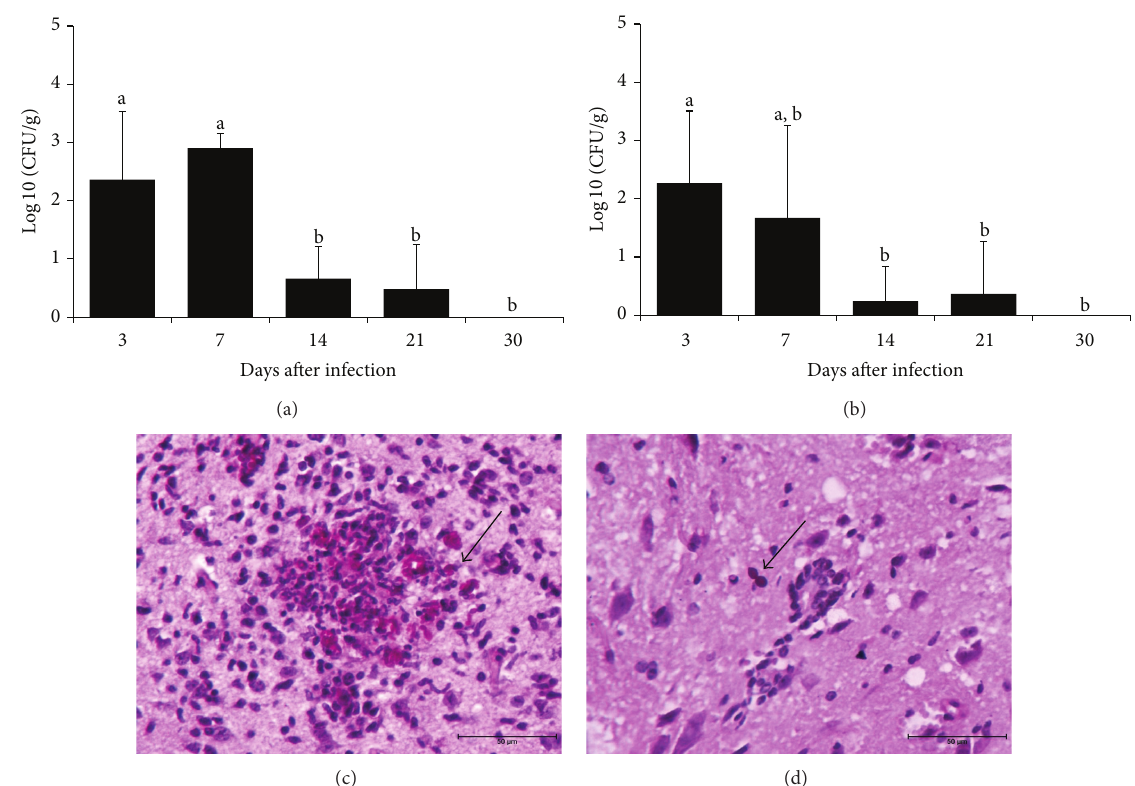
Figure 1: Dissemination of C. albicans to the central nervous system. C57BL/6 mice were infected with C. albicans and fungal load was evaluated 3, 7, 14, 21, and 30 days after in the brain (a) and in the spinal cord (b). The results are expressed as mean ± SEM ( 𝑛 = 5 - 6 mice/group) of the CFU (log 10 ) per gram of tissue. ANOVA, Tukey’s test, 𝑃 < 0.05 . Different letters indicate statistical difference among the experimental time points. Periodic acid-Schiff revealed yeasts and hyphae in brain (c) and yeast in cervical spinal cord (d)